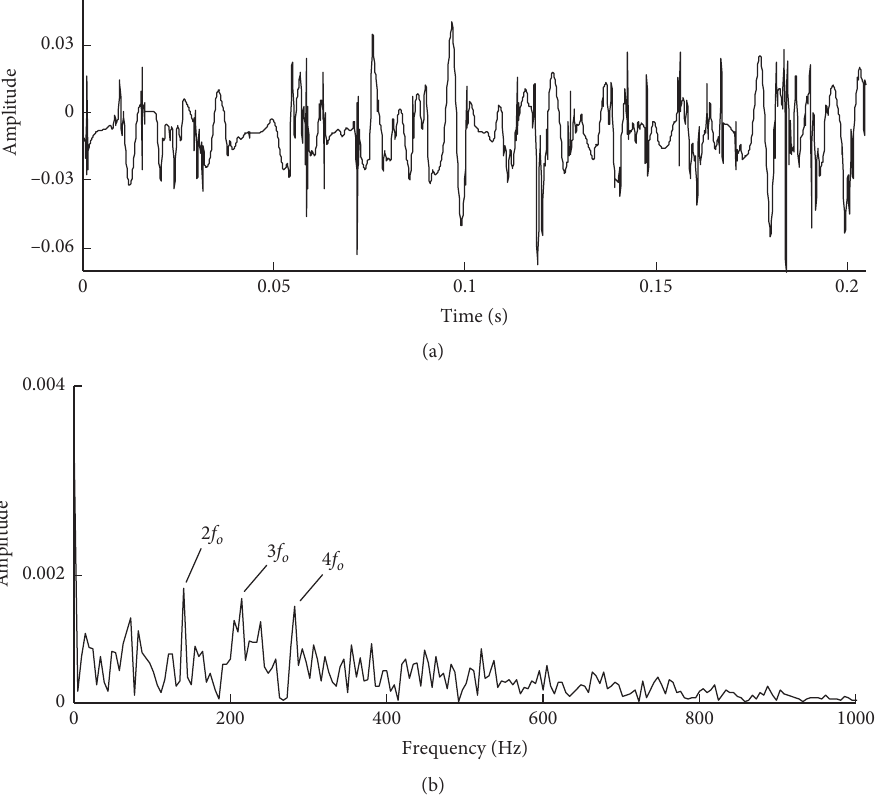
Figure 24: TQWT-SK decomposition result of outer race fault.